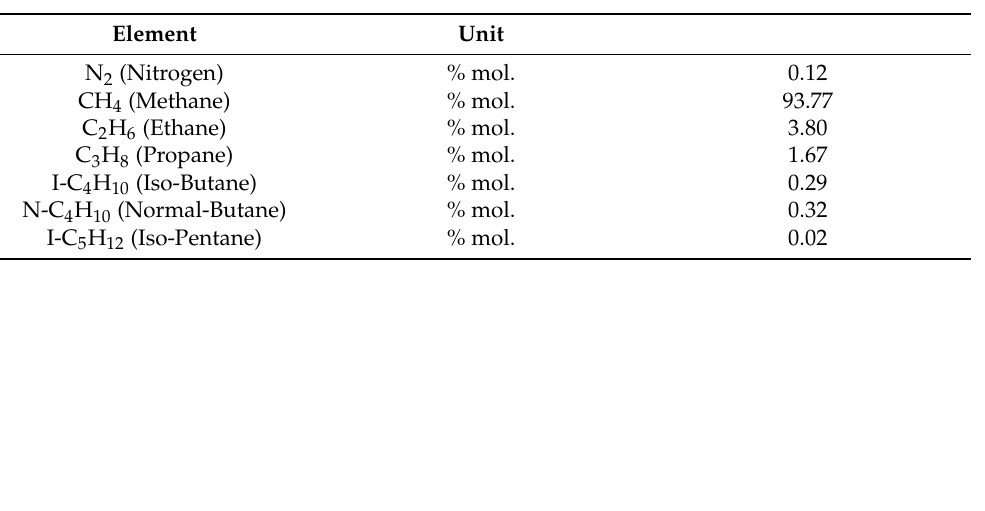
Table 1. LNG (Liquefied Natural Gas)